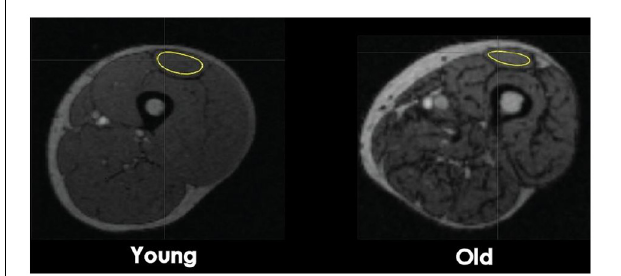
FIGURE 1 | Transaxial CT images at a mid-thigh level. Computed Tomography images of a cross-section of the femoral region from a young and old man subject. The regions of interest (ROI) used for glucose uptake heterogeneity analysis were drawn around the quadriceps femoris (QF) muscles, four knee flexors muscles, and three hip muscles. For muscle volume analysis, ROIs were draw around the four next extensor muscles. ROI of the rectus femoris is shown as an